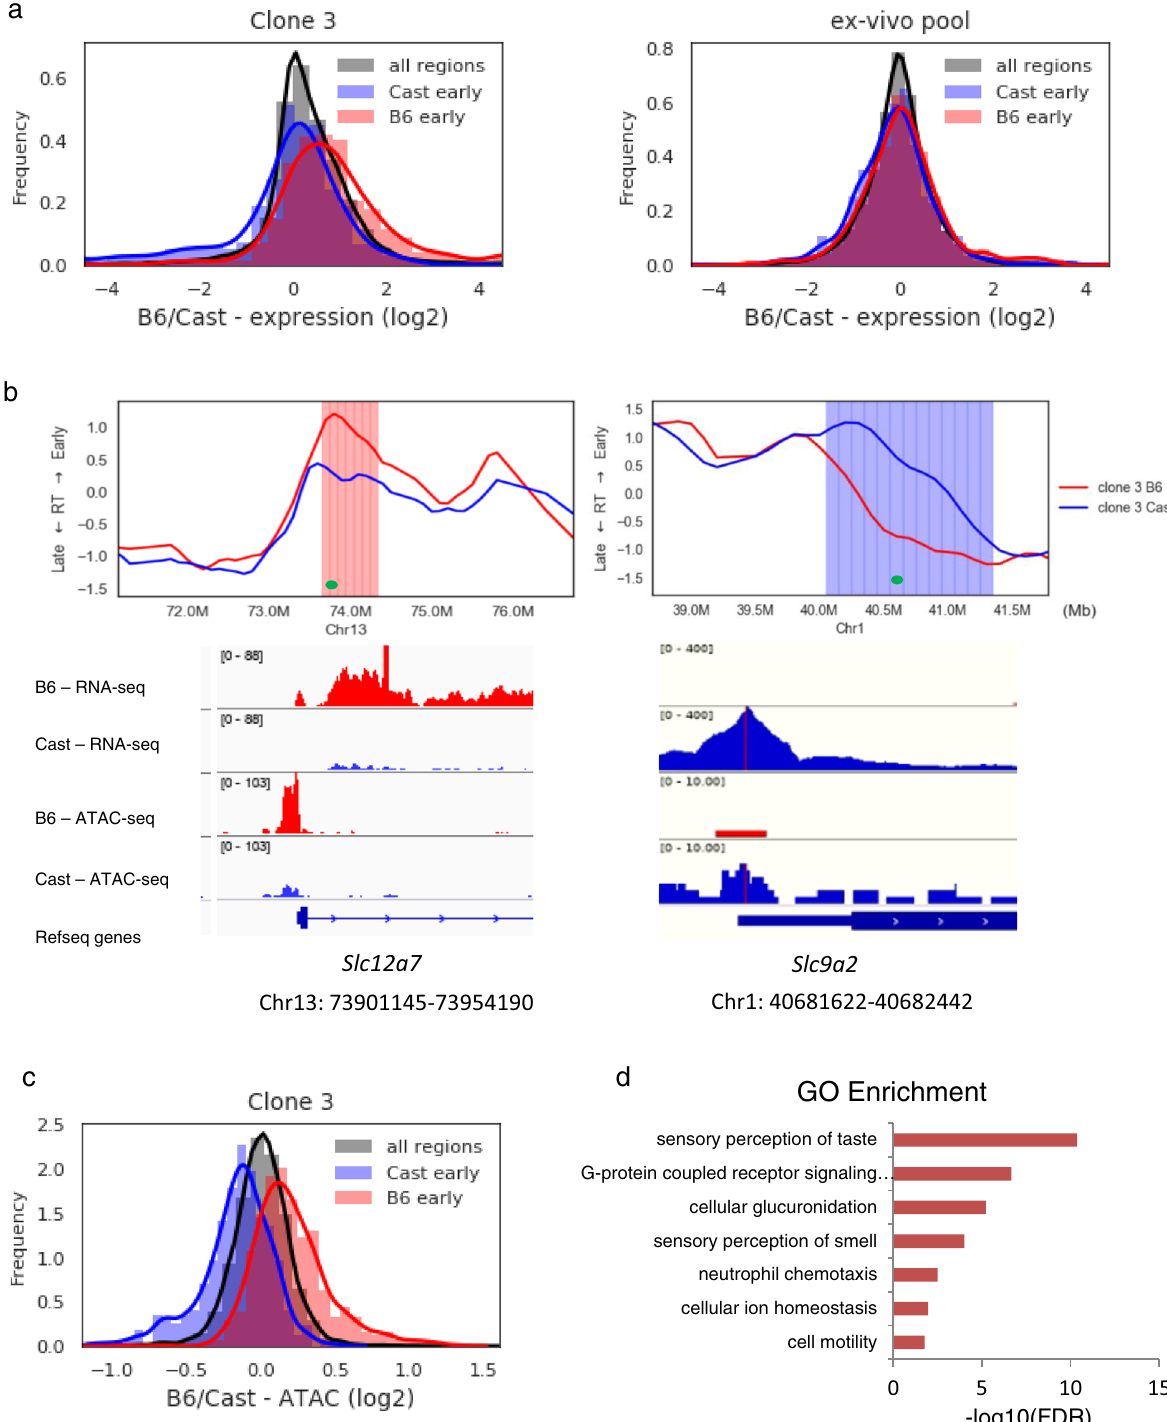
Fig. 3 Characterization of AS-replicating regions. a Distribution plot for expression ratio of Cast early (blue) and B6 early (red) regions (p for difference <10 − 45 ; one-sided t -test) based on allele-speci fi c RNA-Seq data from clone C3 (left) or from an ex-vivo pool of pre-B cells (right). b IGV track depicting gene-speci fi c RNA-Seq coverage and ATAC pro fi le for the B6 (red) and Cast (blue) alleles from two different asynchronously replicating regions in clone C3. The AS-RT replication patterns are shown above each example. Slc12a7 is in a B6 early region, while Slc9a2 is located in a Cast early replicating region, as determined by whole-genome analysis. c Distribution plot of ATAC-seq ratios ( p < 10 − 98 ; one-sided t -test). d Gene ontology bar plot of asynchronously replicating